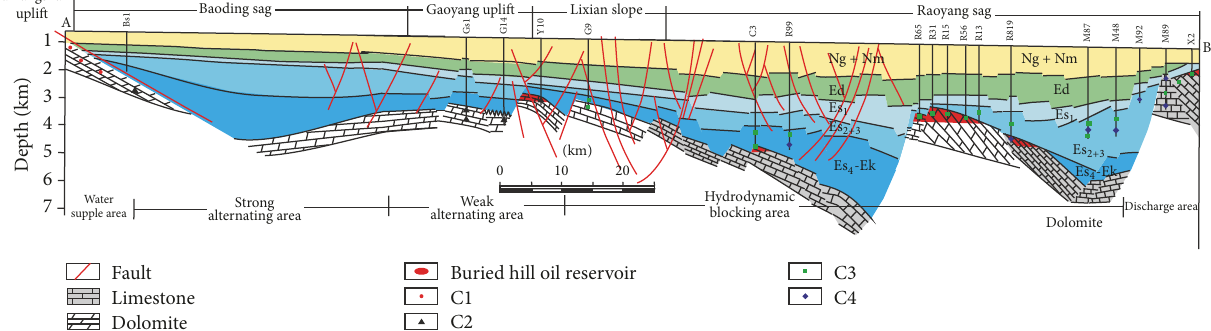
Figure 3: Schematic map of the cross-section A-B. See Figure 1.